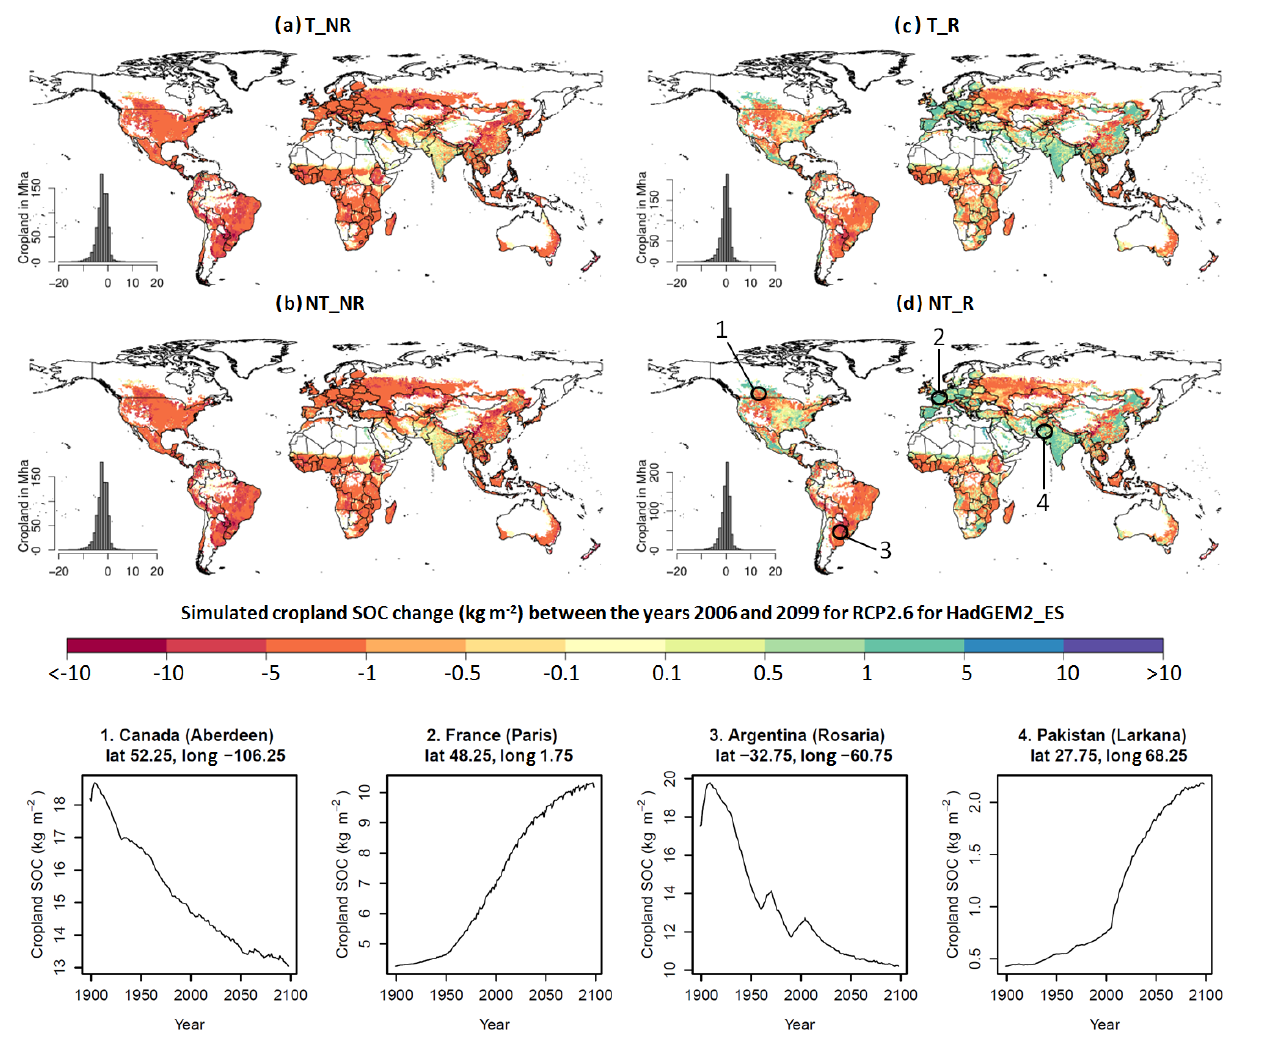
Figure 4. Simulated cropland SOC change (kgm − 2 ) between the years 2006 and 2099 (kgm − 2 ) for RCP2.6 for GCM HadGEM2-ES for the four different management options (T_R, NT_R, T_NR, and NT_NR). Plots 1–4 show examples of SOC development (kgm − 2 ) from the years 1900 to 2099 for different explanatory regions as shown on the map (d) (NT_R). The difference maps of affected change categories between RCP2.6 and RCP8.5 are shown in Fig. 5. Maps for GFDL-ESM2M, IPSL-CM5A-LR and MIROC5, and RCP8.5 are in the Supplement (Figs. S7 to